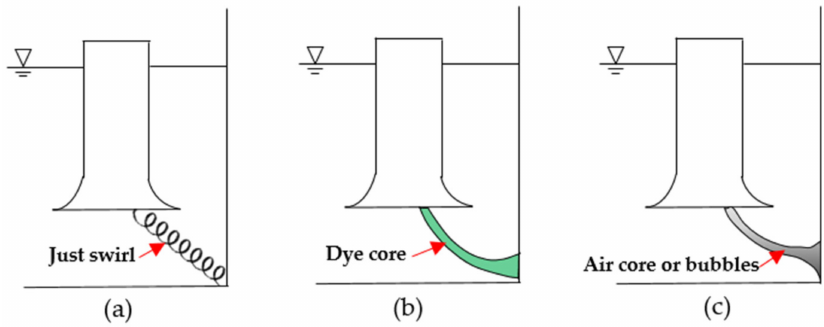
Figure 1. Classification of subsurface vortex: ( a ) Type 1; ( b ) Type 2; ( c ) Type